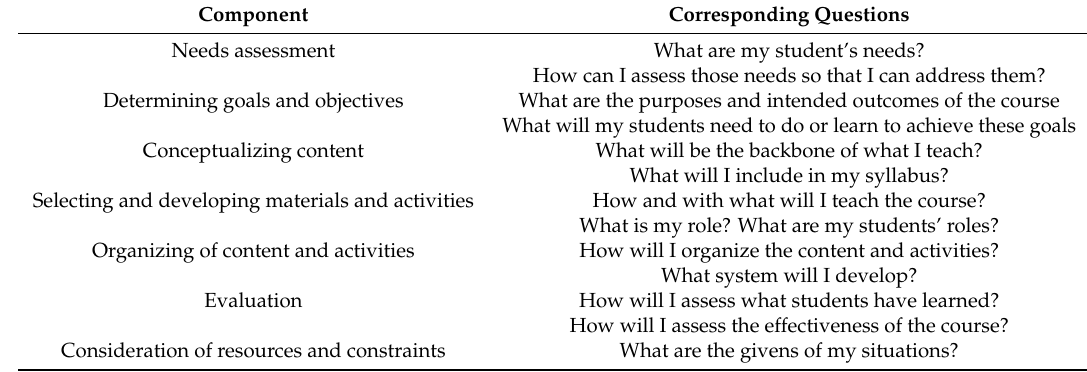
Table 1. Course design components and questions in relation to each component, compiled from Graves